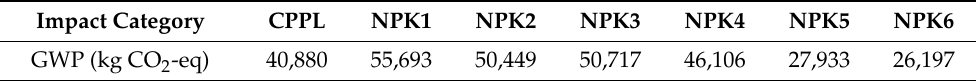
Table 14. Global warming potential values from other scientific publications compared to this study. Impact Category CPPL NPK1 NPK2 NPK3 NPK4 NPK5 NPK6 GWP (kg CO 2 -eq)